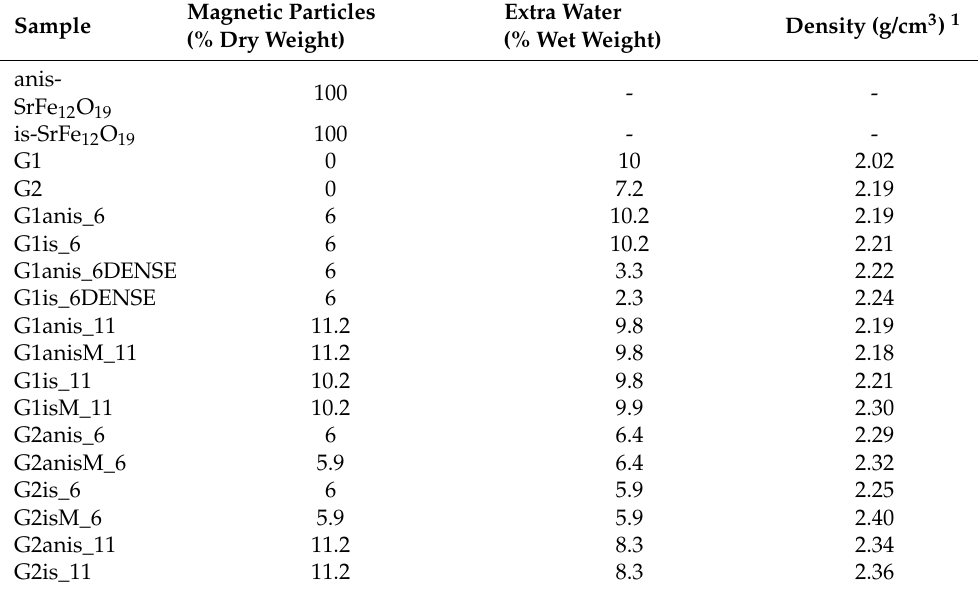
Table 2. Samples’ composition and density